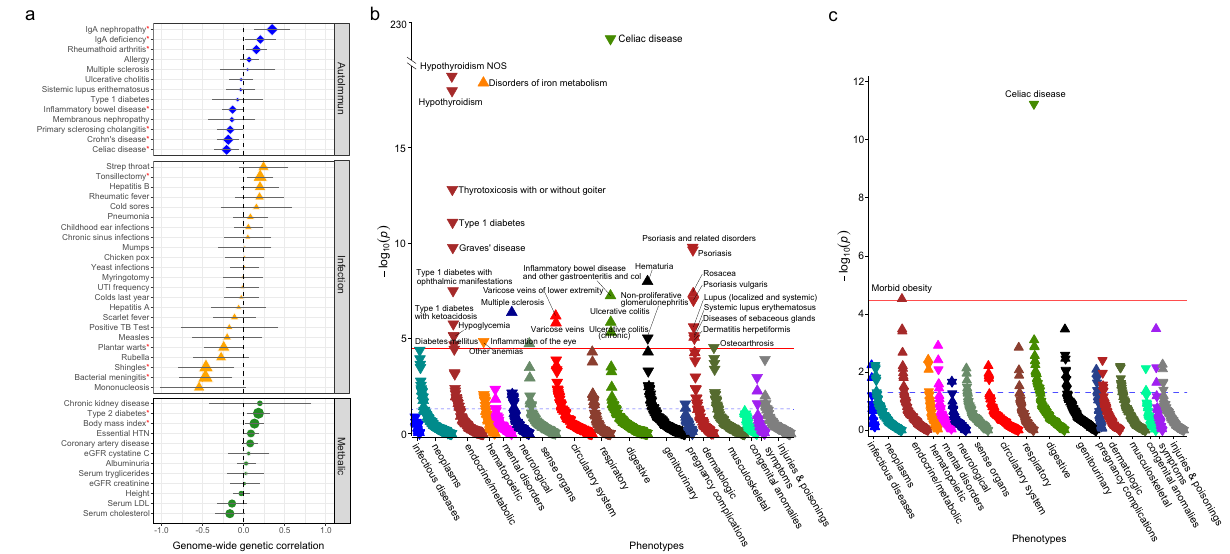
Fig. 6 | Genetic relationships between IgA levels and human disease traits. a genome-wide genetic correlation analyses between IgA levels and autoimmune, infectious, and cardio-metabolictraitsafter exclusionofthe HLA region (* P <0.05; two-sided unadjusted P -values for genetic correlation by LD score regression). Supplementary Table 12 provides genetic correlations with and without HLA with P -values for each trait, and references to the original GWAS studies; the error bars correspondto95%con fi denceintervalsforgeneticcorrelationcoef fi cients. b Meta- PheWAS of genome-wide polygenic score (GPS) for IgA levels across eMERGE-III and UKBB biobanks (total N = 556,656). c Meta-PheWAS of GPS for IgA levels withouttheHLAregion(UKBBandeMERGE-III,total N =556,656).In( b )and( c ),the y -axis shows – log10 ( P -value); each triangle represents an individual phenotype